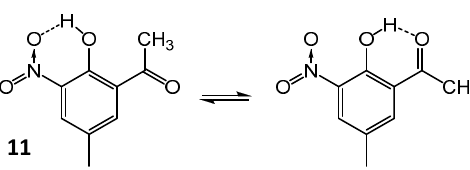
Figure 13. Scheme of the hydroxyl group isomerization in 5-methyl-3-nitro-2-hydroxyacetophenone ( 11 ).